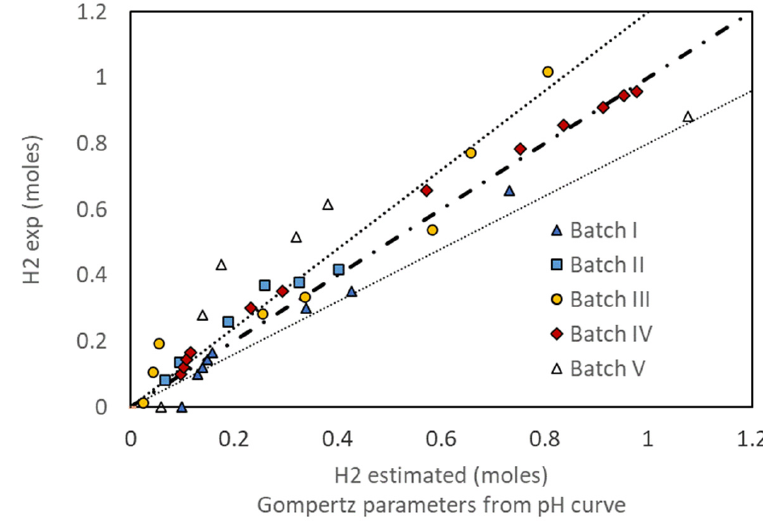
Figure 8. Comparison of experimental moles of H 2 vs. those predicted by the modified Gompertz model using parameters fitted from the experiments and the pH curve.